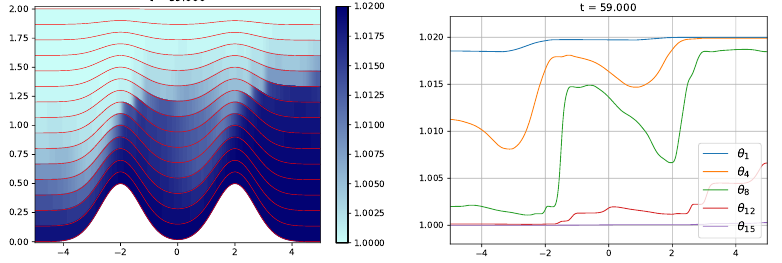
Figure 37. Distribution of θ for a cut in the plane y = 0 (upper row) and x = − 2 (lower row).